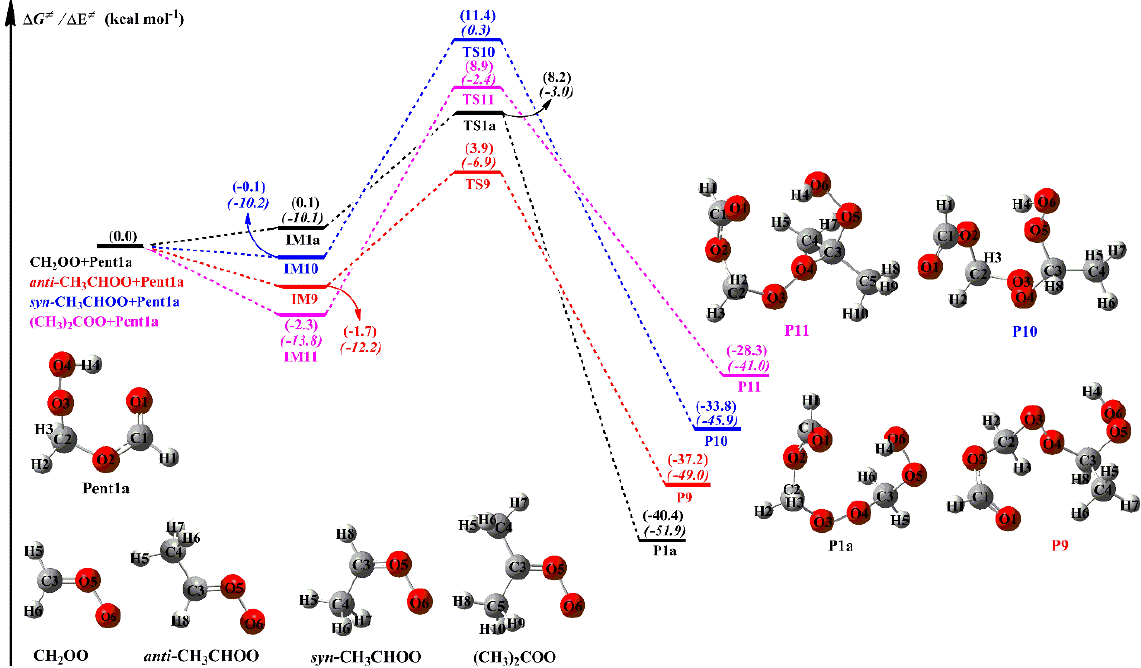
Figure 6. PES ( (cid:49)G and (cid:49)E ) for the distinct SCI + Pent1a reactions at the M06-2X/ma-TZVP//M06-2X/6-311 + G(2df,2p) level of theory. Table 2. The reported concentrations of the coreactant, the rate coefficients k , and the effective pseudo-first-order rate constants ( k eff = k [coreactant]) for distinct SCI reactions with HPMF, H 2 O, HCOOH, and SO 2 in tropical forest